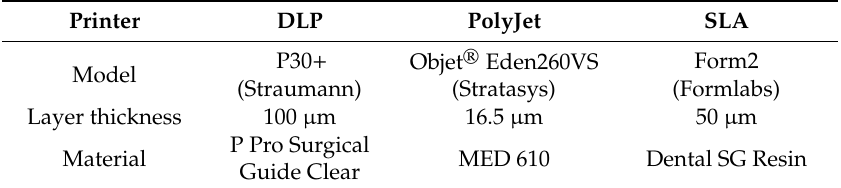
Figure 2. Implant surgical guides fabricated by ( a ) DLP, ( b ) PolyJet, and ( c ) SLA printers. Table 1. Brief description of di ff erent 3D